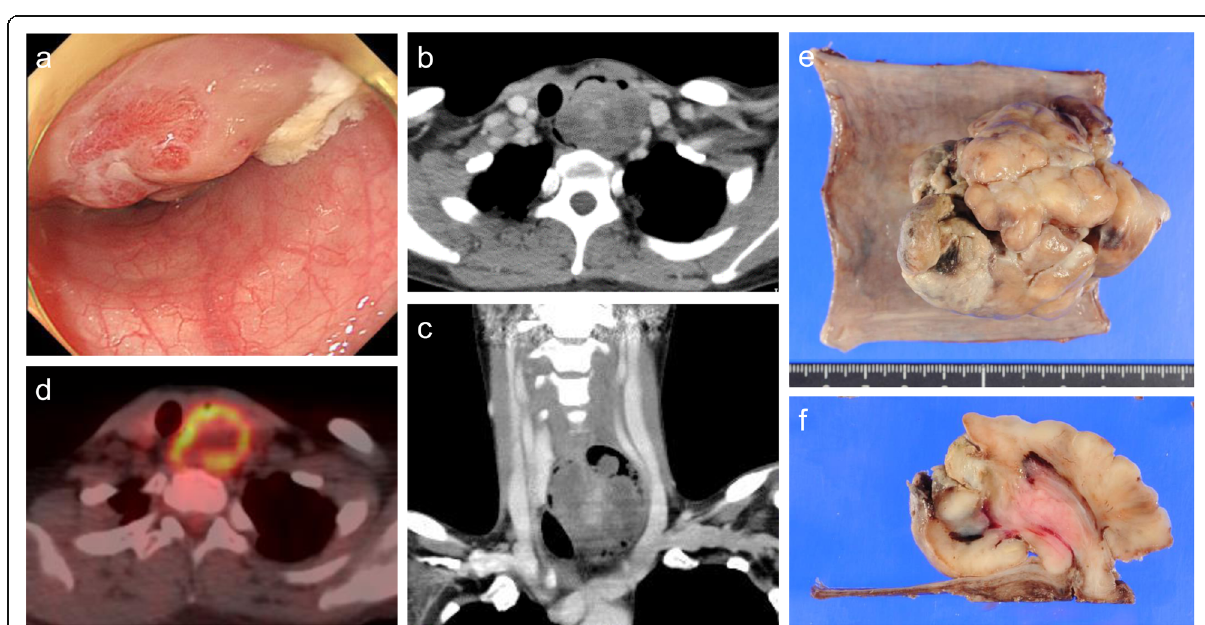
Fig. 2 Images obtained before the second surgery. Esophagoscopy showed a 70-mm-sized protruding tumor ( a ). Contrast-enhanced CT showed a well-circumscribed mass in the cervical esophagus ( b , c ). FDG-PET/CT showed FDG uptake in the esophageal tumor ( d ). Macroscopic findings of the secondary tumor. It was pedunculated and multilobulated and covered by the thinning esophageal mucosa ( e ), while its incised surface was whitish tan and had areas of focal hemorrhage ( f )